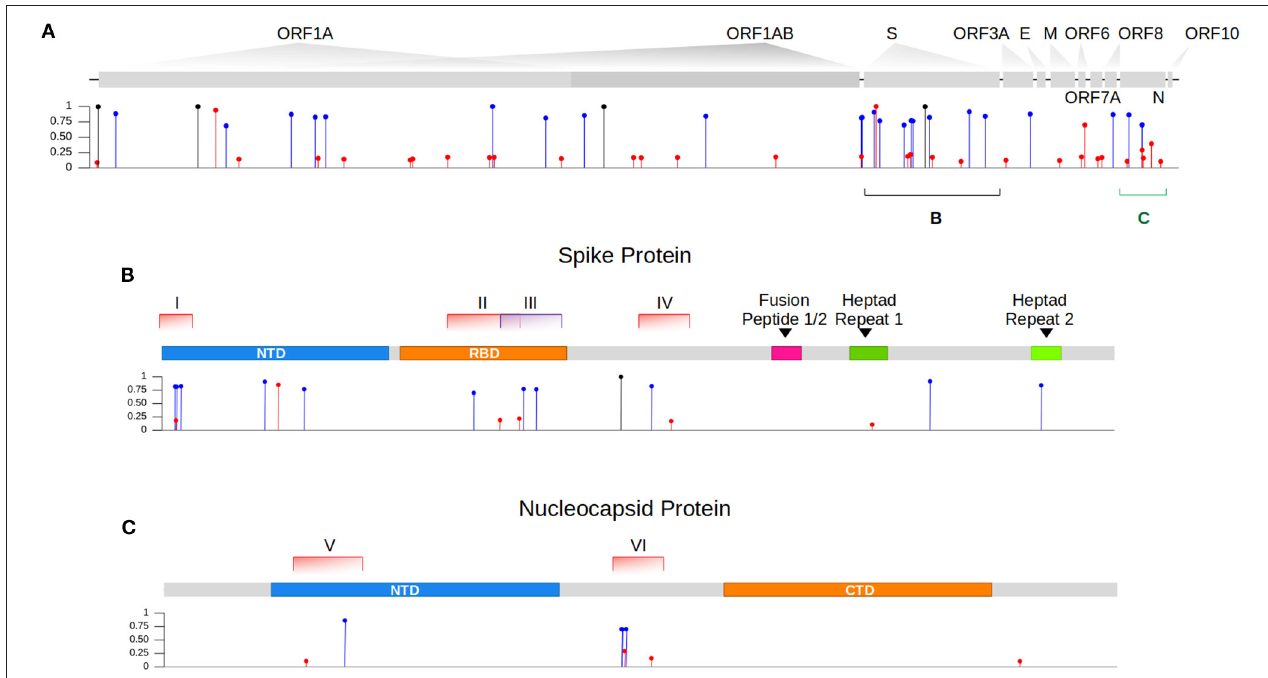
FIGURE 1 | Intra-host single nucleotide variant frequencies evidence coinfection by two genetically distinct lineages. (A) Identification of iSNVs across the different genes of the SARS-CoV-2 genome within our sample. In blue and red, we showed the lineage-defining mutations from the variant Gamma and Delta, respectively. iSNVs represented in black are mutations commonly found in both lineages that descend from their ancestor B.1. (B) Zoom in gene S showing the location of each genomic window (I-IV) where recombination events were investigated. (C) Zoom in gene N showing the distribution of both selected regions (V and VI) across the